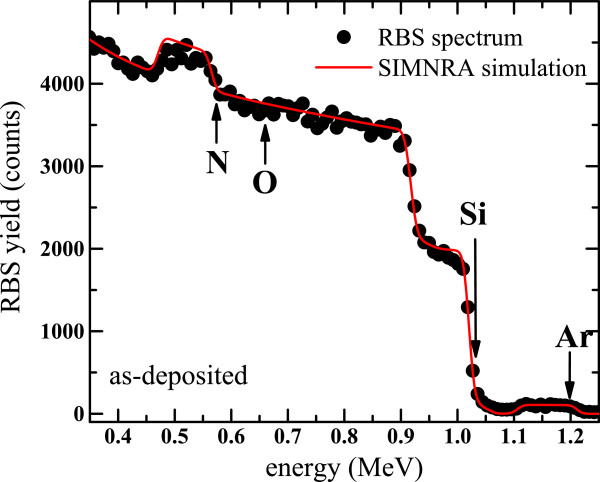
RBS spectrum of a SiNxlayer with the corresponding SIMNRA simulation curve. The film was deposited on a Si substrate by the N2-reactive method. Surface peaks of N, O, Si, and Ar are indicated by arrows.